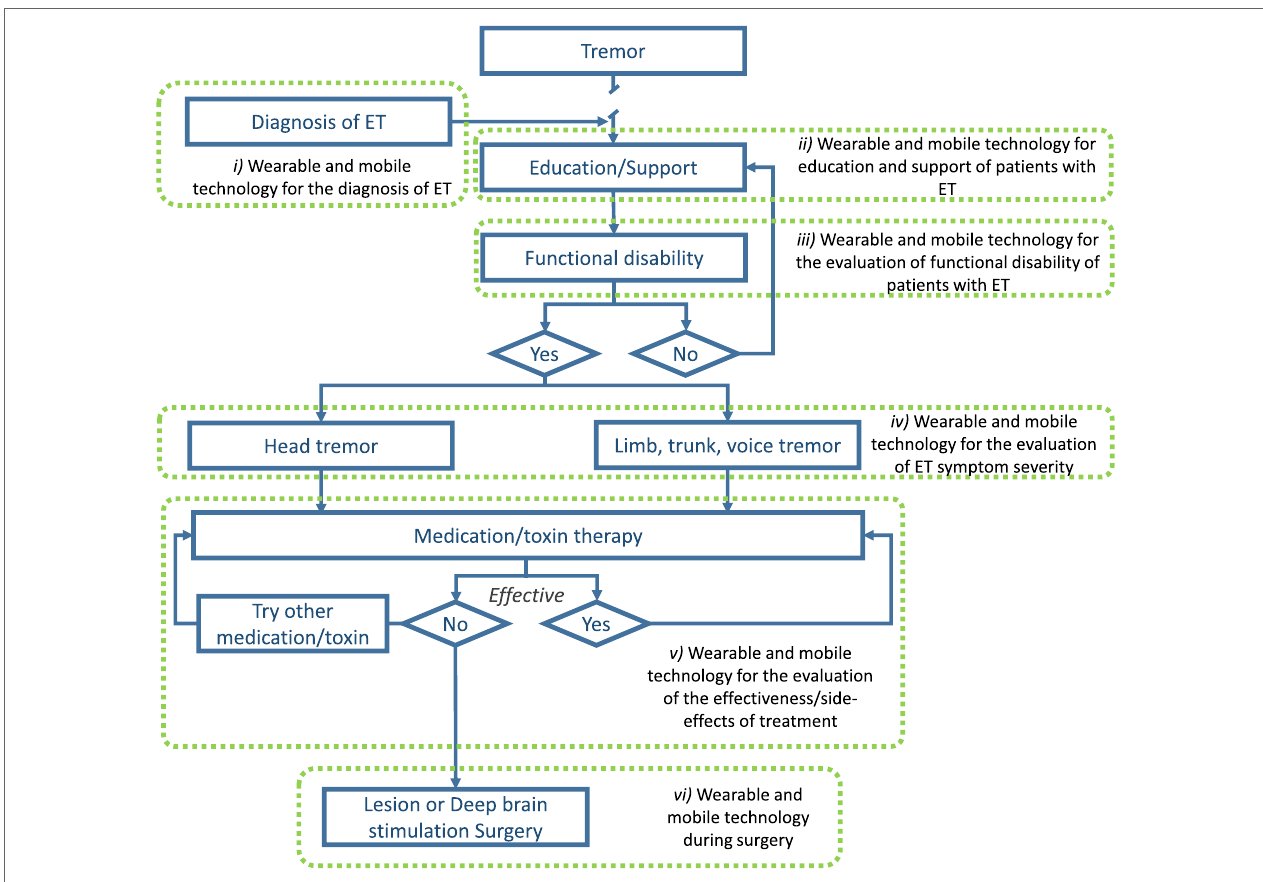
FiGUre 1 | Illustration of areas where wearable and mobile technology could be utilized to improve the management of ET. Adapted from Gironell and Kulisevsky (45) with